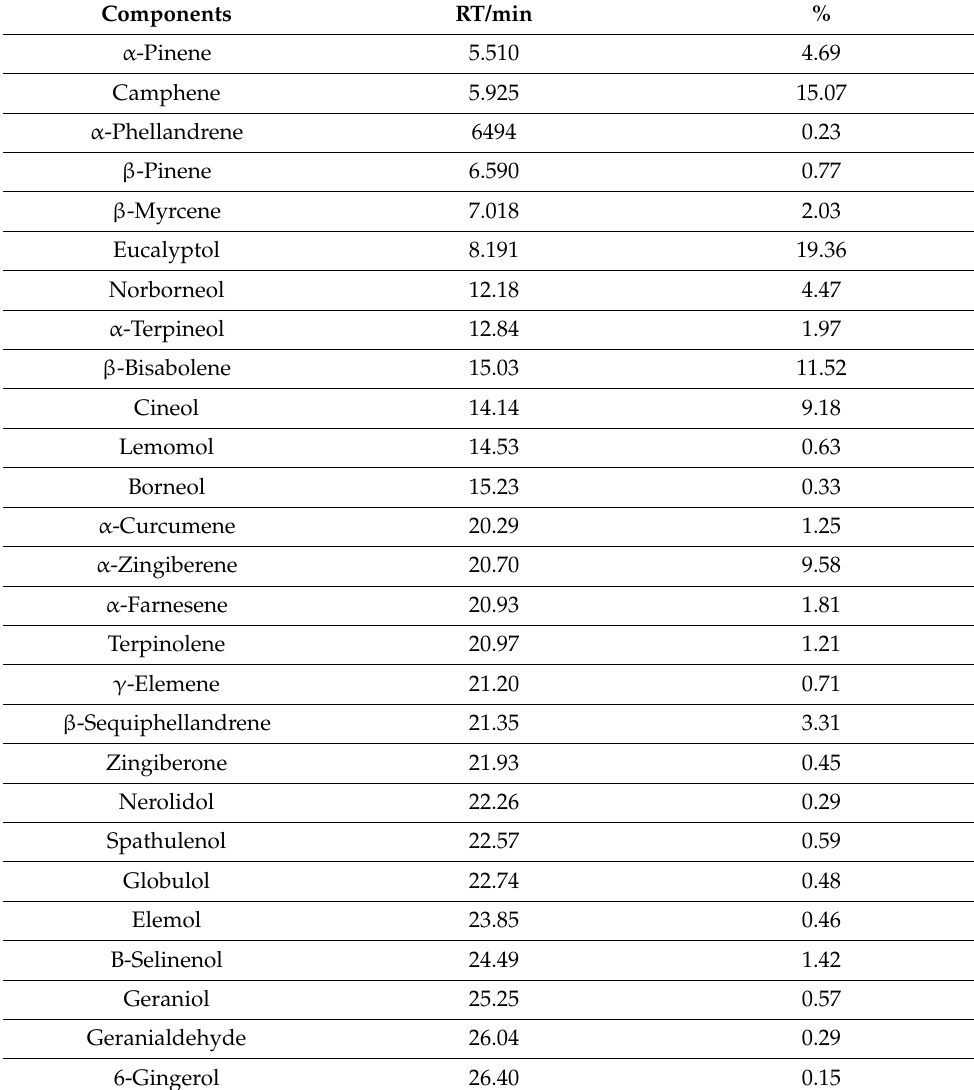
Table 1. Chemical composition of GEO using GC/GC-MS